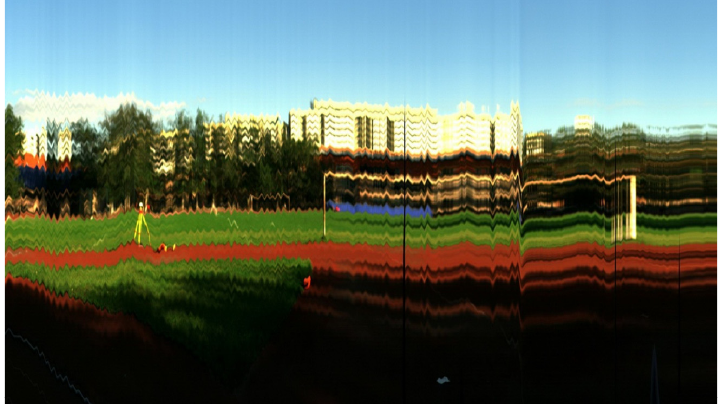
Figure Figure 5. The raw image acquired by GBC with the side-scanning mode. (it includes geometric distortions).